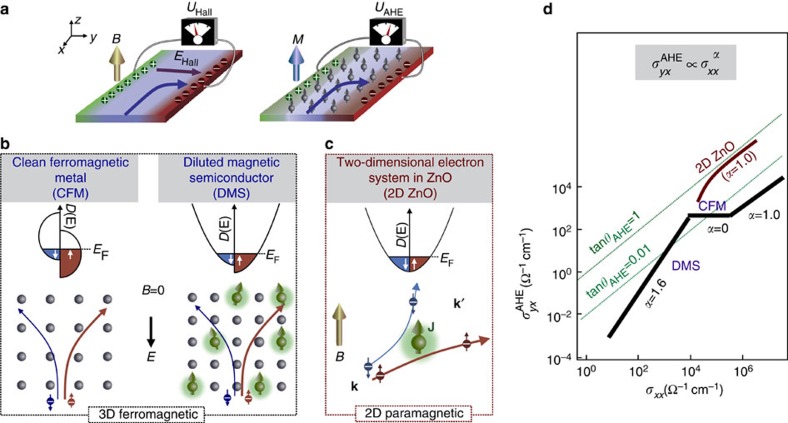
Concept of anomalous Hall effect.(a) Hall voltage is built in the magnetic field B due to the Lorentz force (left panel) and due to the spin–orbit coupling in ferromagnetic material with the total magnetization M (right panel). (b) Appearance of anomalous Hall effect: electrons are deflected in the mean field of spontaneously ordered magnetic moments. (c) Anomalous Hall effect in a paramagnetic system, such as ZnO, is brought about by the spin-dependent electron scattering on localized magnetic moment J. (d) Schematic representation of anomalous Hall effect scaling behaviour found in various materials67.